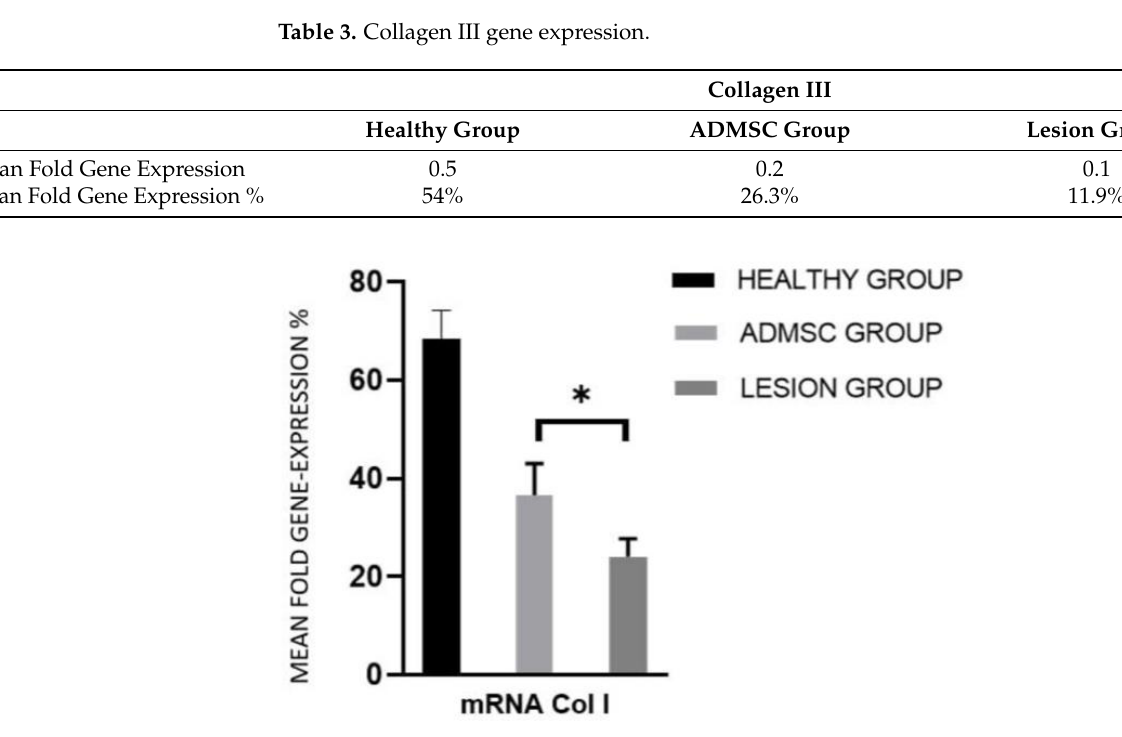
Figure 4. Mean fold gene expression % for collagen I relative to GAPDH in healthy, ADMSC, and lesion groups determined by quantitative RT-PCR. Standard error of the mean (SEM) is also depicted. * p < 0.05.